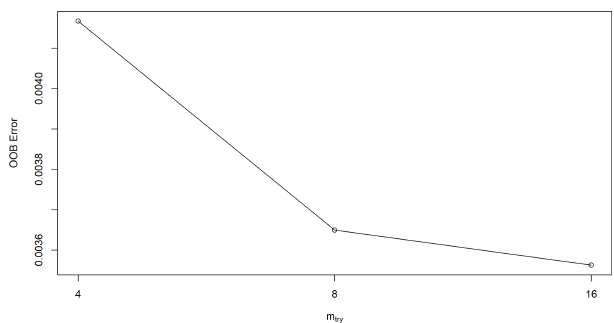
Figure 8. Tuned randomForest algorithm for the optimal number of variables randomly sampled as candidates at each split (mtry)